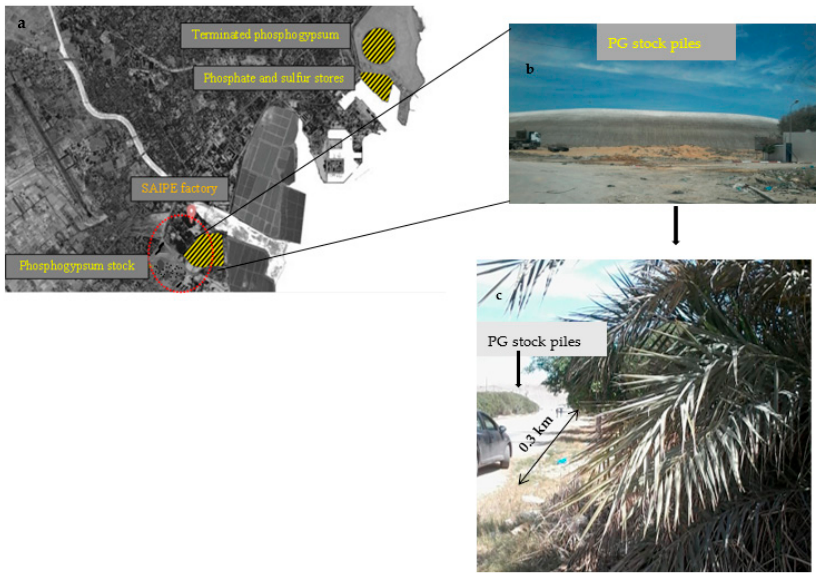
Figure 1. Show study area ( a ) in Sfax region (34°44 ′ 52.249 ″ N 10°45 ′ 58.187 ″ E), southern Tunisia (237 km), were the phosphogypsum (PG) stockpiles of the Industrial Society of Phosphoric Acid and Fertilizers (ISPAF) factory ( b ). Soil and plant sample collections from about 0.3 km far away from PG stockpiles ( c ).